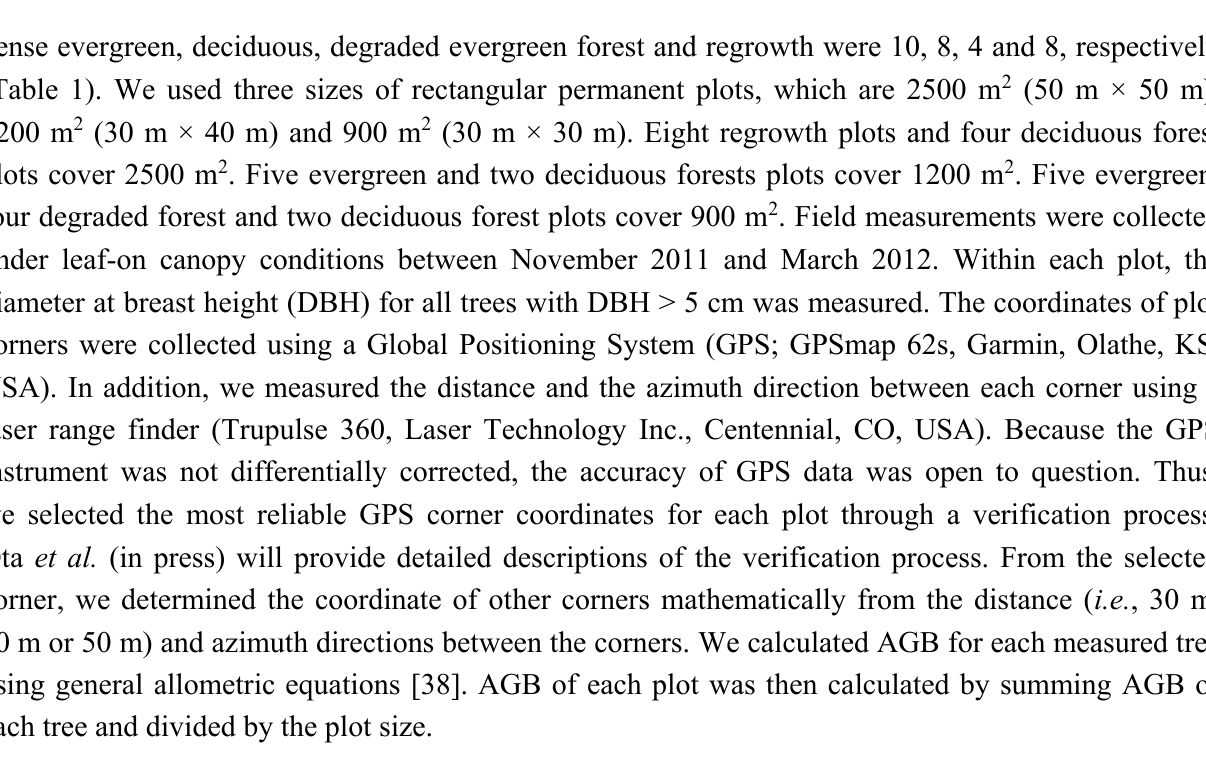
Table 1. Summary of field measurements of aboveground